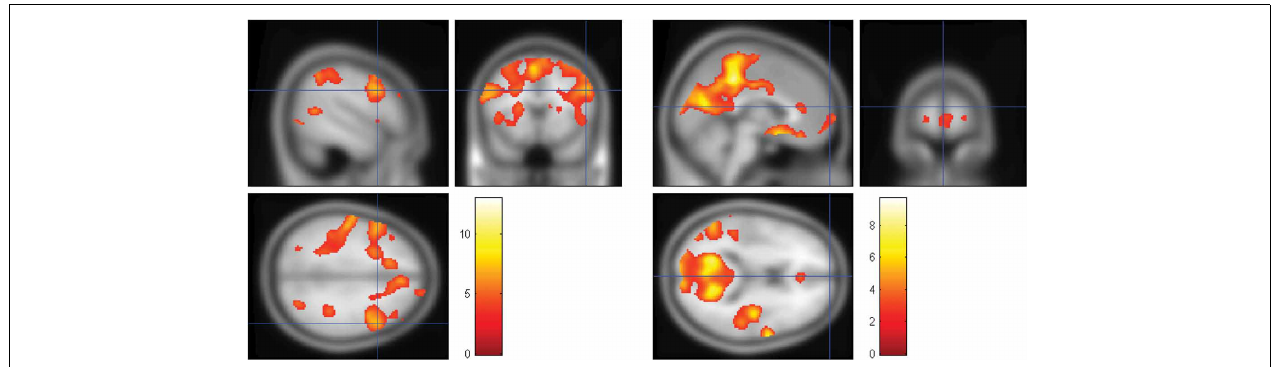
FIGURE 5 | The locations of statistically significant activations for the MSIT, after second-level analysis across seven participants. The expected “task-positive” and “task-negative” hemodynamic activations occurred in the same regions that were interrogated by the fNIRS probes. Left : the t -statistic is mapped, with the height threshold set at an uncorrected significance level of p < 0 . 001 and the extent threshold